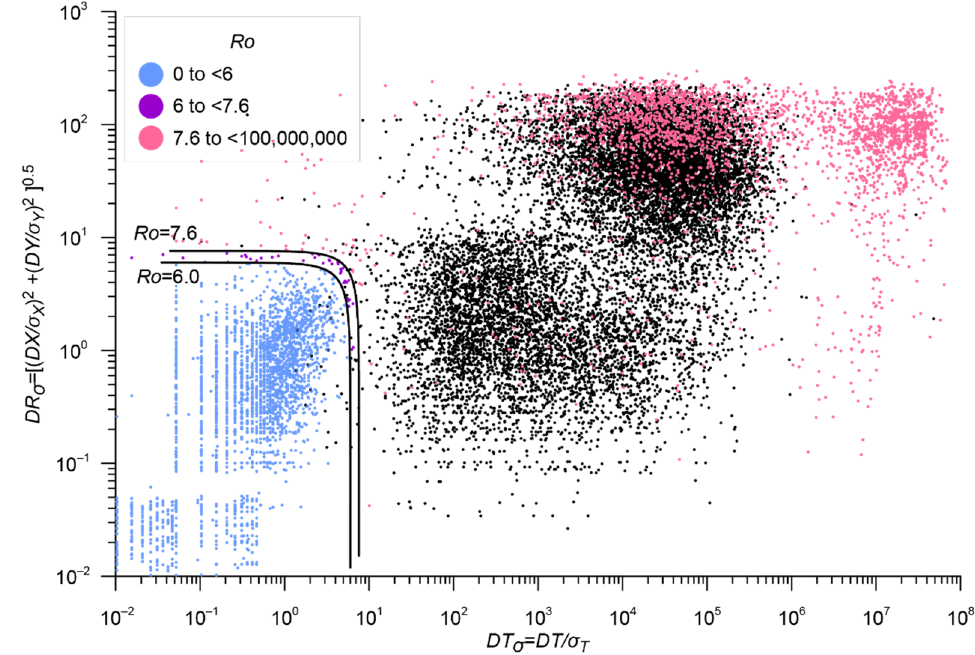
Figure 9. Distribution of normalized DT and DR , and metric level lines (1). The colored dots are the RUS/ISC_Other pairs and the black dots are the distances between the RUS/RUS events in metric (1). The metric levels Ro = 6 and Ro = 7.6 are shown by the black lines, and absolute duplicates are not shown.